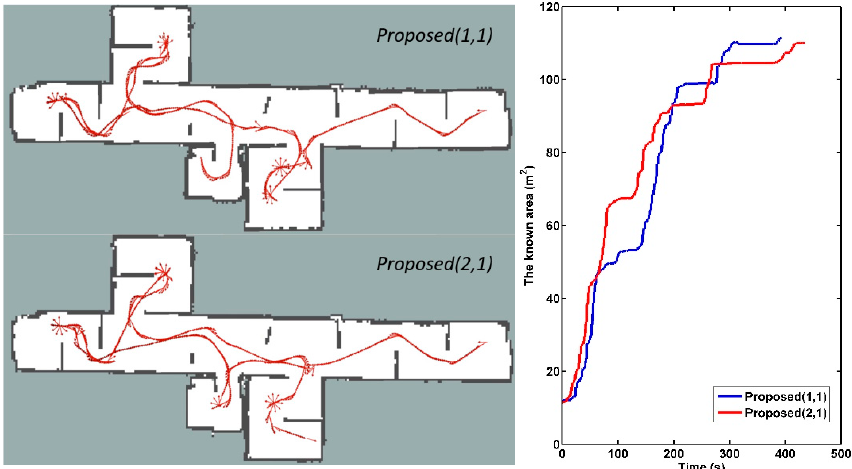
Figure 12. The performance of exploration experiments with the shortest path under different pa-